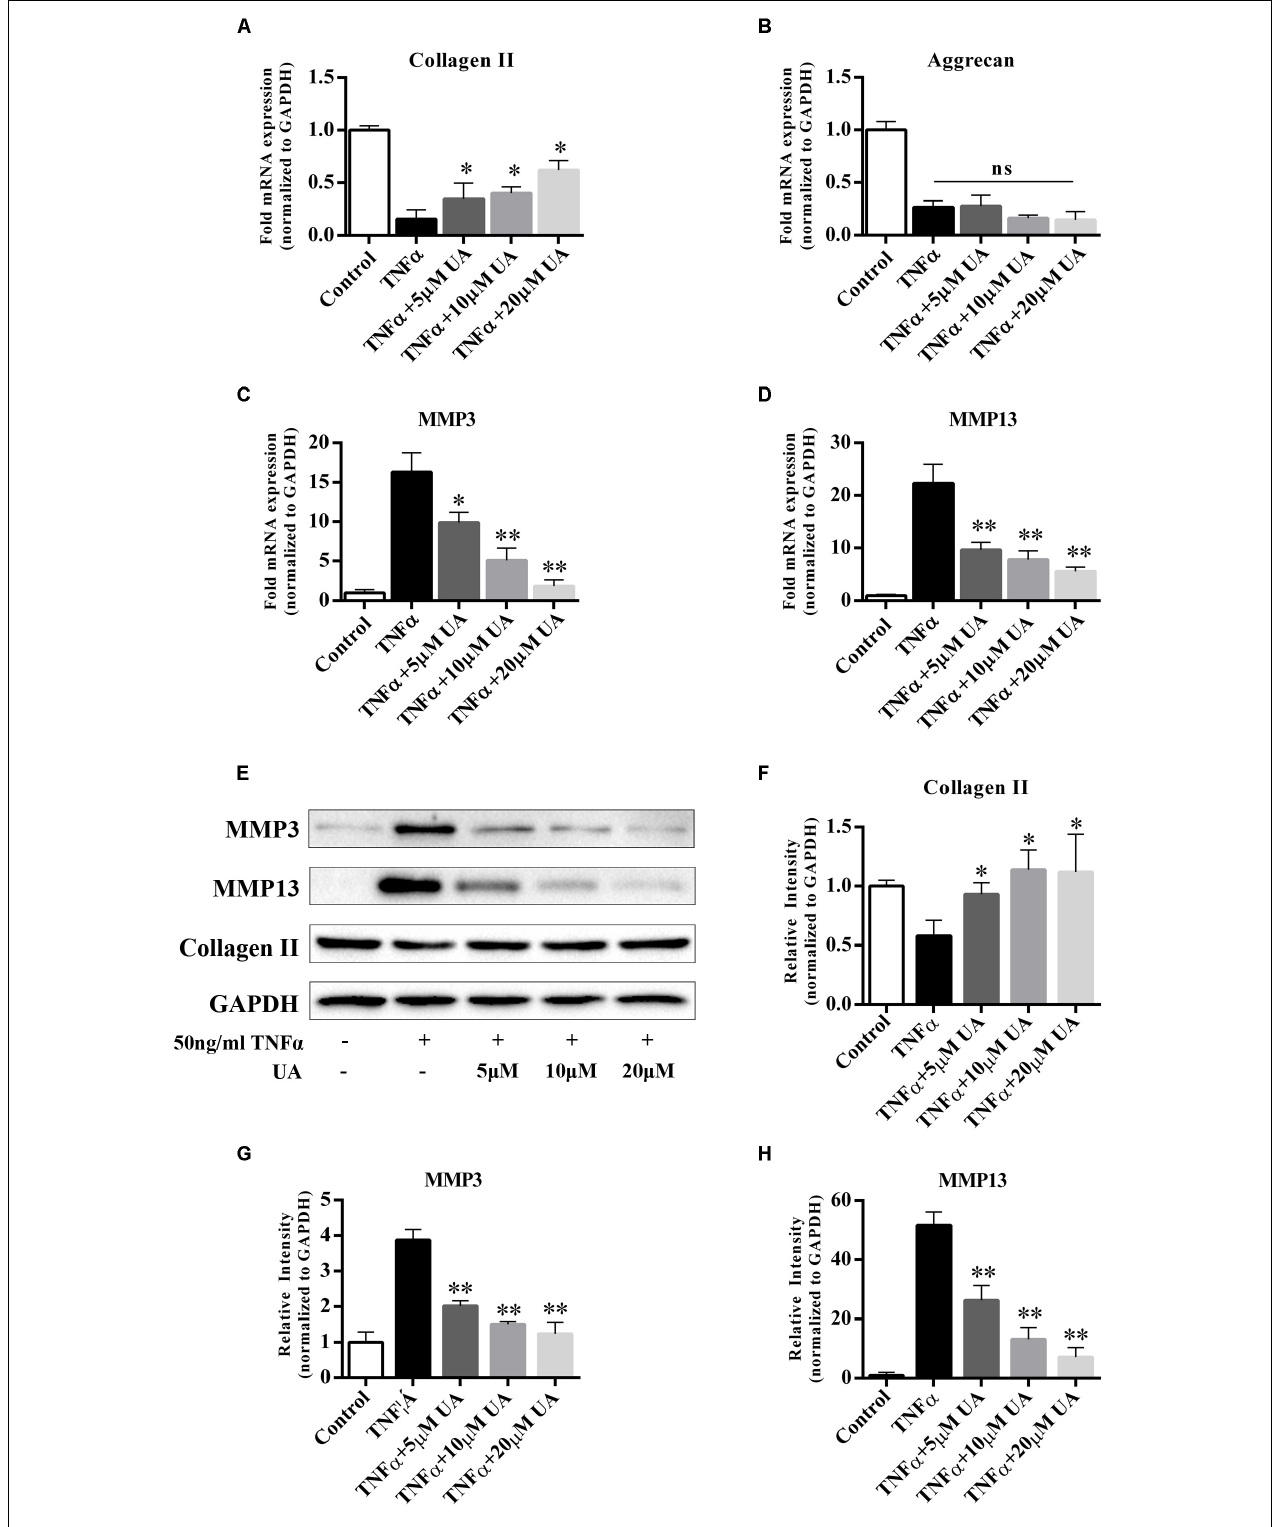
FIGURE 2 | Effects of UA on anabolic/catabolic genes and protein expression in NP cells induced by TNF α . NP cells were pretreated with UA at the indicated concentrations for 2 h, and then 50 ng/ml of TNF α was added in serum-free media for 48 h. (A–D) The mRNA expression levels of collagen II, aggrecan, MMP3, and MMP13 were measured by qPCR. (E–H) The protein expression was measured by using western blotting. The results were quantified using ImageJ software. Gene expression was normalized by GAPDH expression. The data represent the means ± SD. ∗ P < 0.05, ∗∗ P < 0.01 compared with samples only treated with TNF α .